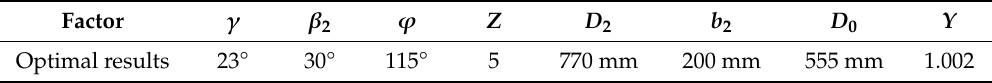
Table 4. Optimal combination of impeller geometrical parameters.